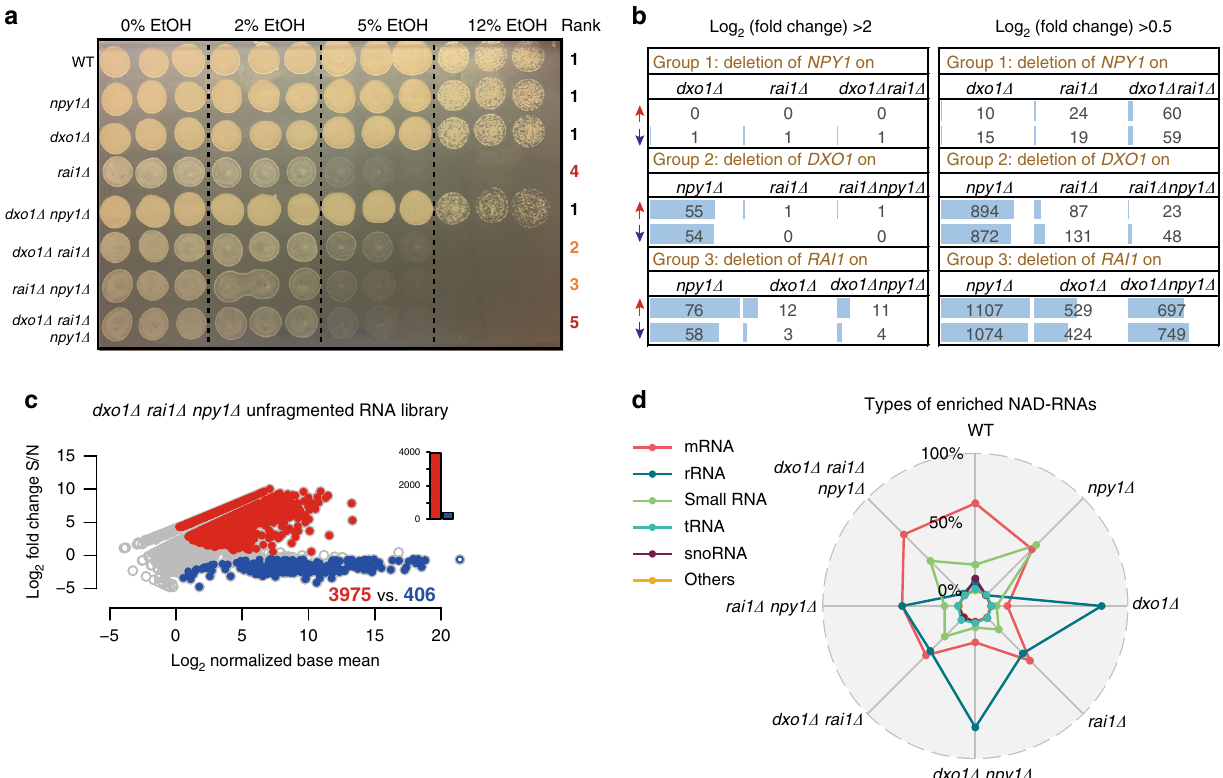
Fig. 5 Enzyme deletions in fl uence the NAD-RNA landscape. a Growth phenotype of the WT and mutant yeast strains in the presence of different ethanol concentrations. The rank of approximate growth density is given on the right side. Each condition was tested in triplicates. Strain names are denoted on the left. b Effect of the deletion of one particular enzyme in different strains on the upregulation (red arrows) or downregulation (blue arrows) of RNA species, assessed by transcriptome sequencing. Group 1 summarizes the deletion of the NPY1 gene from the single mutants ( dxo1 Δ , rai1 Δ ) and from the double mutant ( dxo1 Δ rai1 Δ ). Groups 2 and 3 show deletion of the DXO1 gene and of the RAI1 gene, respectively. The number of RNA species with log 2 FC > 2 is shown on the left panel, whereas with log 2 FC > 0.5 is shown on the right panel. c Enriched NAD-RNAs in the unfragmented NAD captureSeq library of the dxo1 Δ rai1 Δ npy1 Δ strain. All parameters are as in Fig. 1a. Performed in biologically independent replicates, n = 3. d Radar plot of the distribution of different classes of enriched NAD-RNAs (in %) in different deletion strains. The colors indicate the type of RNAs, enumerated on the left. Source data are provided as a Source Data fi